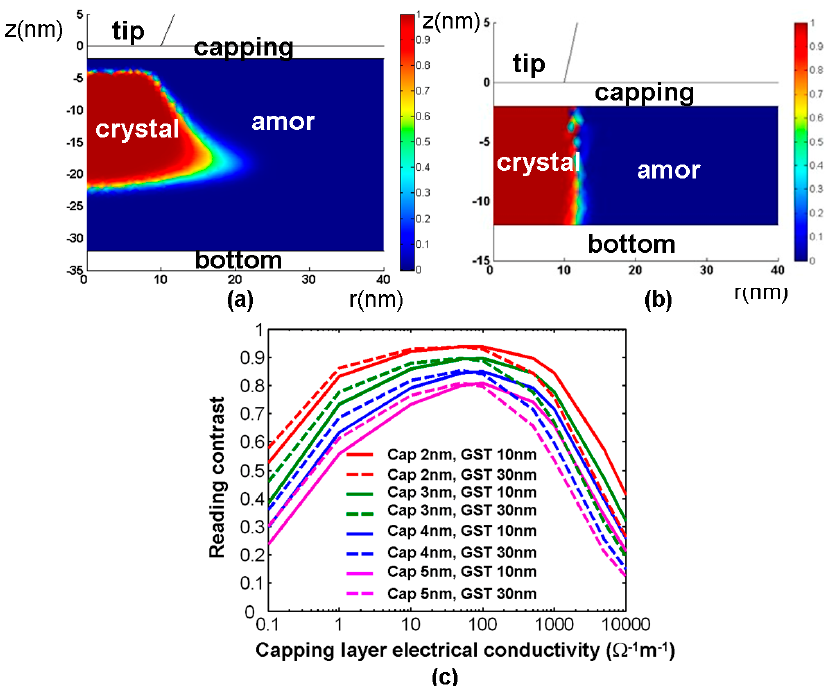
Figure 12. The resulting crystalline bit from a GST layer with a thickness of ( a ) 30 nm and ( b ) 10 nm, and ( c ) the resulting reading contrast as a function of the GST layer thickness for a single crystalline bit. Reproduced with permission from [7]. Copyright Ieee Xplore, 2006; [27]. Copyright Springer, 2014; [37]. Copyright IOP Science, 2014.